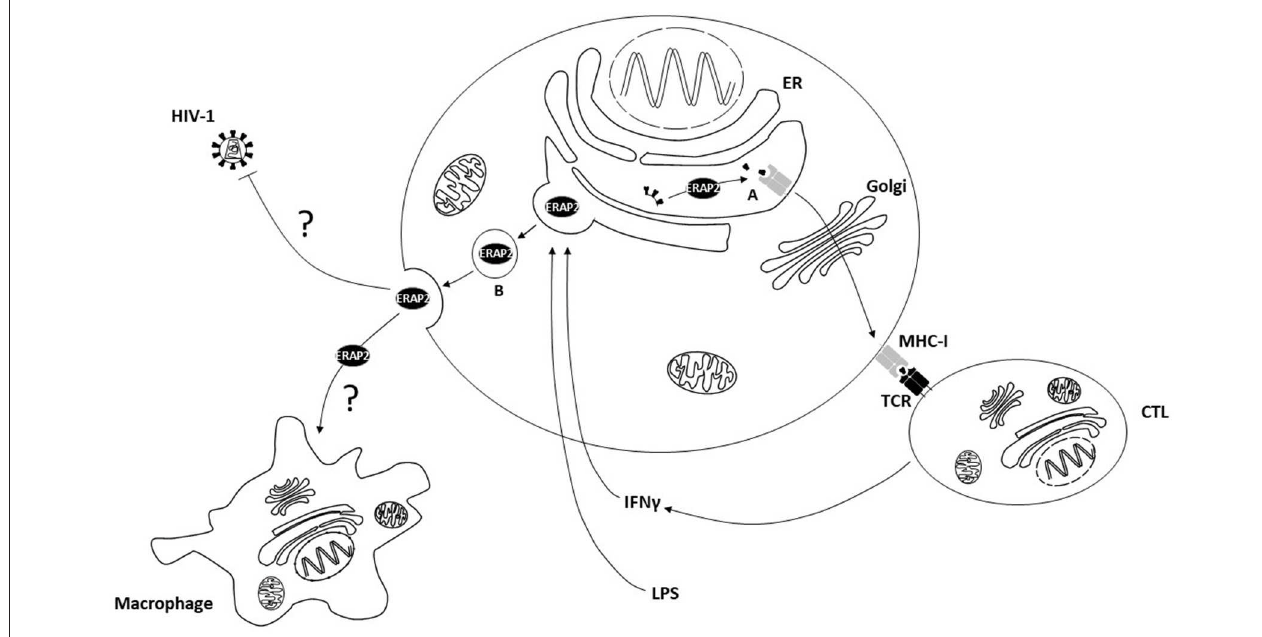
FIGURE 7 | The cellular localization and functions of ERAP2. (A) Intracellular ERAP2 plays a key role in editing peptide quality and, in turn, cytotoxic T lymphocyte (CTL) repertoire shaping and activation. (B) Following interferon γ (IFN γ ) and lipopolysaccharides (LPS) stimulation ERAP2 may be released in the secretome of immune competent cells where it interferes with HIV-1 replication through direct or indirect mechanisms, possibly involving macrophage activation. ER, Endoplasmic Reticulum; MHC-I, Major Histocompatibility Complex class I; TCR, T Cell